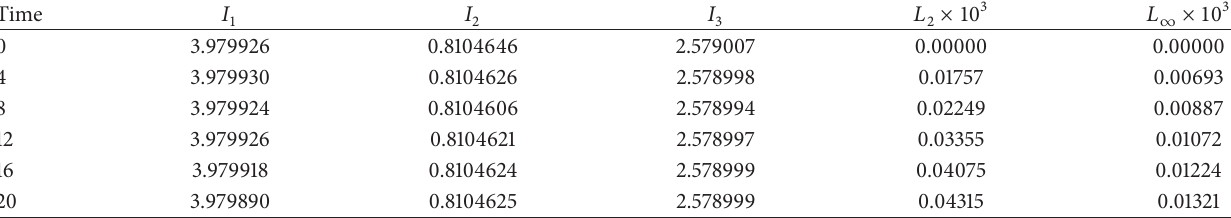
Table 2: Table of values obtained by Daˇg et al. [7] using a splitted quadratic B-spline collocation method. Time 𝐼